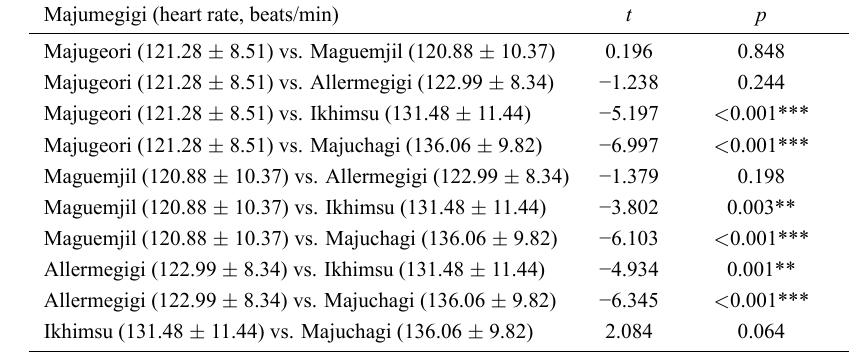
Data are expressed as mean ± standard deviation.